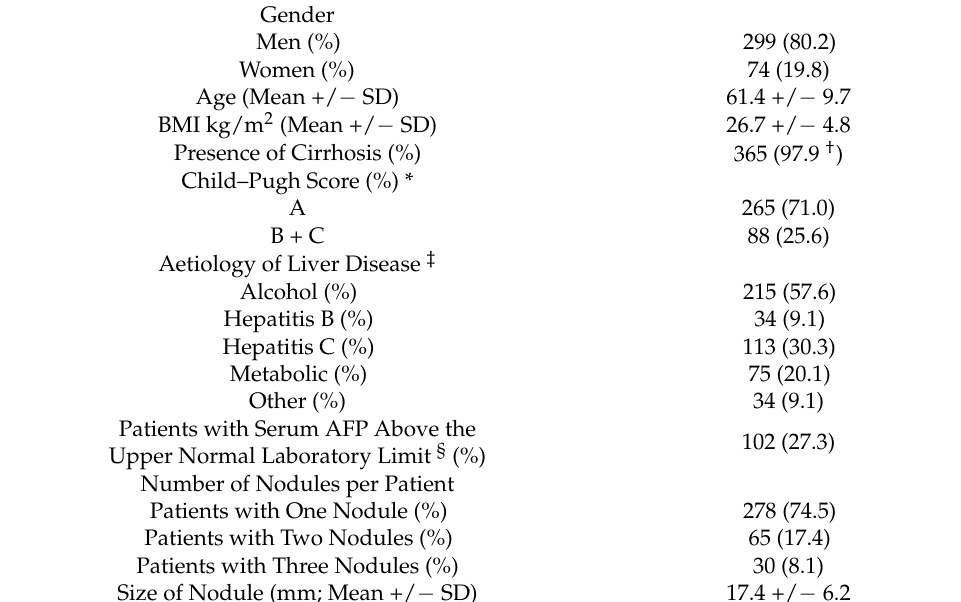
Table 1. The characteristics of the patients.